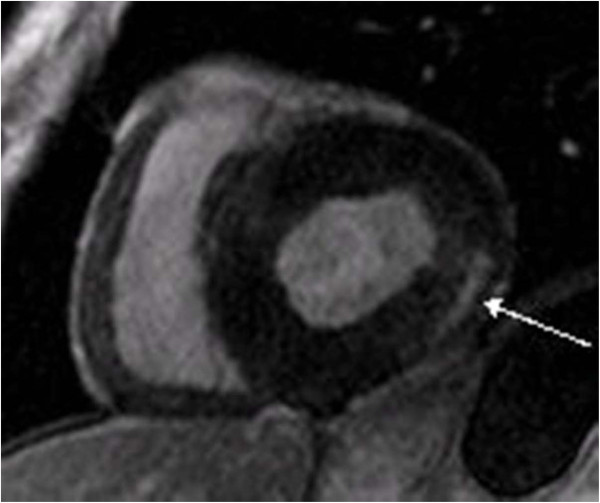
Cardiac fibrosis. A magnet resonance imaging short axis view of a 54-year-old male Fabry patient. The arrow indicates the late enhancement positive region of the left ventricle.